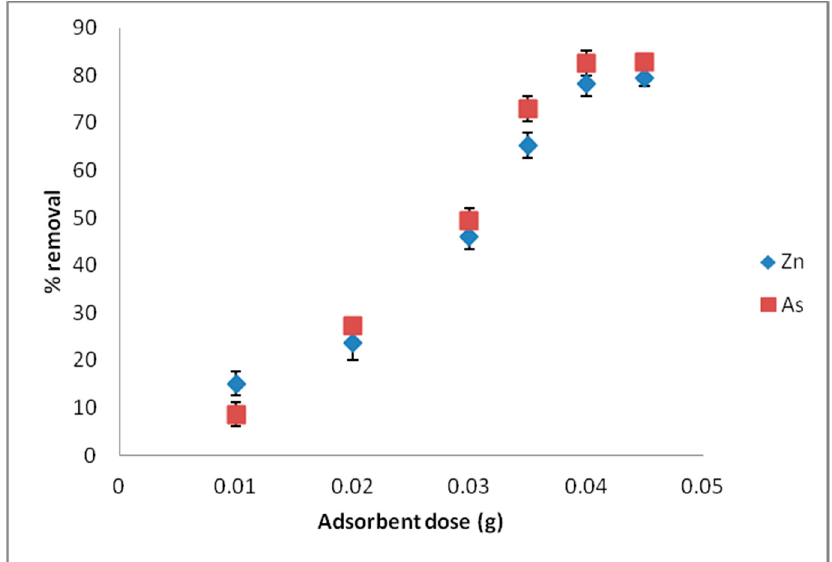
Figure 4. Effect of MNP-Maph dose on the uptake of Zn(II) and As(III) from aqueous solutions (conditions: 100 mg L − 1 20 mL adsorbate solution, 20 °C temperature, 4 h contact time, 200 rpm and pH 6.7 for Zn(II), and 6.0 for As(III)).